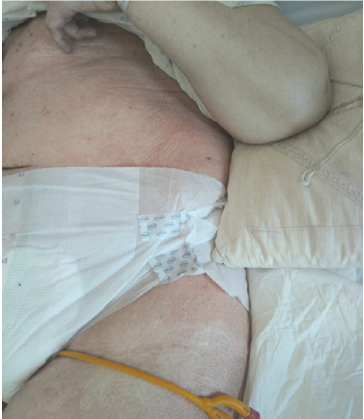
Figure 1: Extensive pustular rash located on the folds and proximal limp sessions.